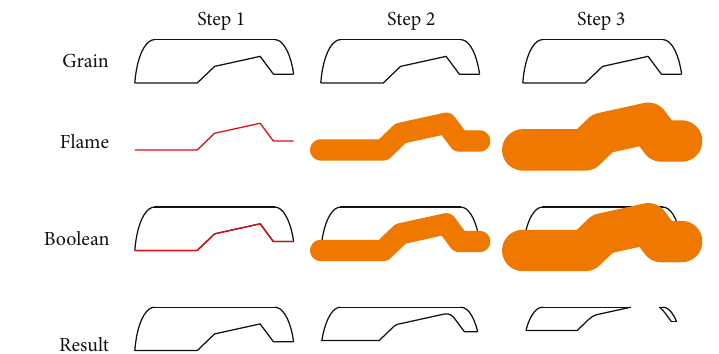
Figure 2: Avoiding sharp edges.